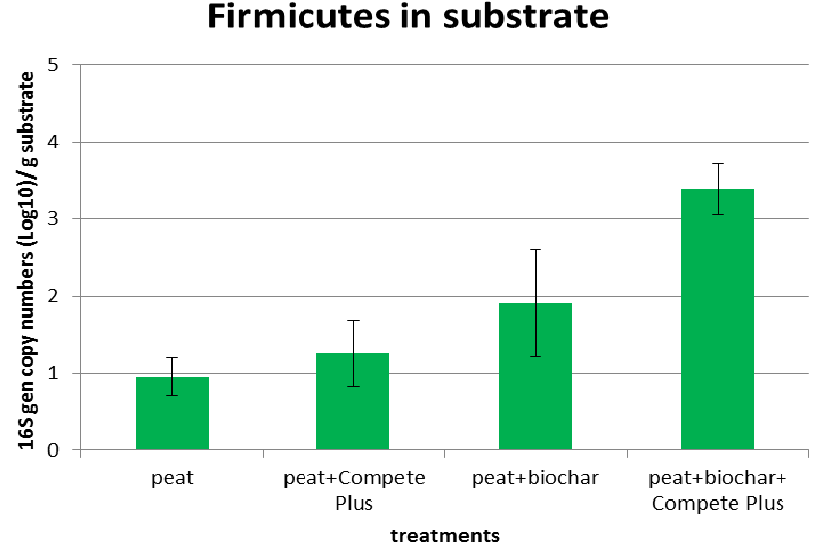
Figure 8. Firmicutes numbers (on basis of log10 of copy numbers of 16S gene per g dry medium).